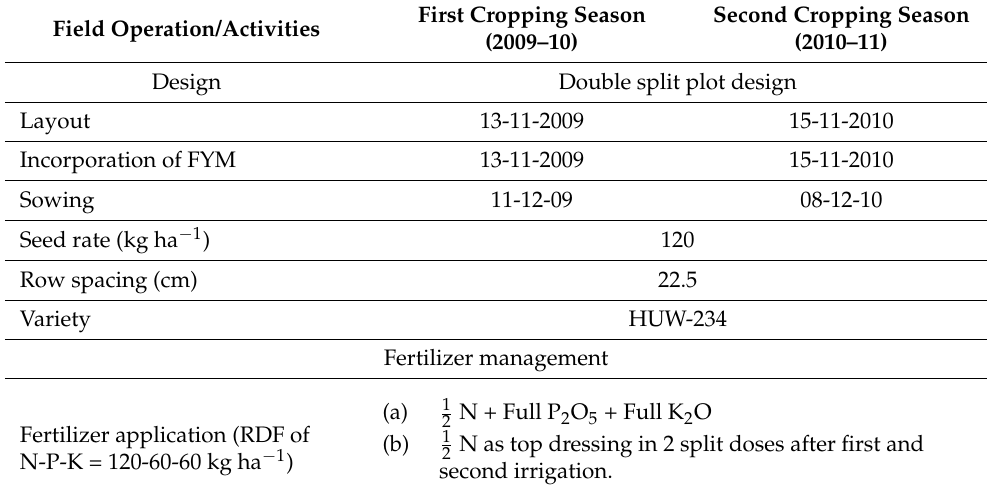
Table 1. The schedule of field operations followed during the crop growth period (Rabi, 2009–10 and